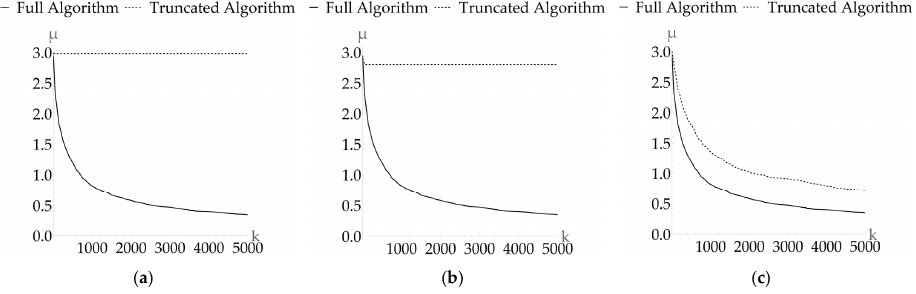
Table 2. The values of the genetic algorithm parameters used in the calculations.